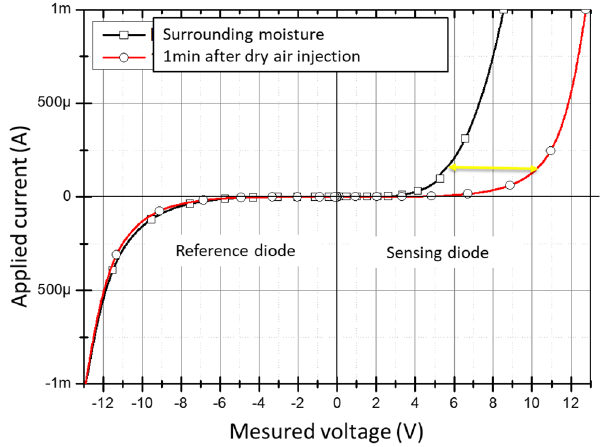
Figure 8. Characterization of the diodes set under ambient atmosphere and dry air flow.